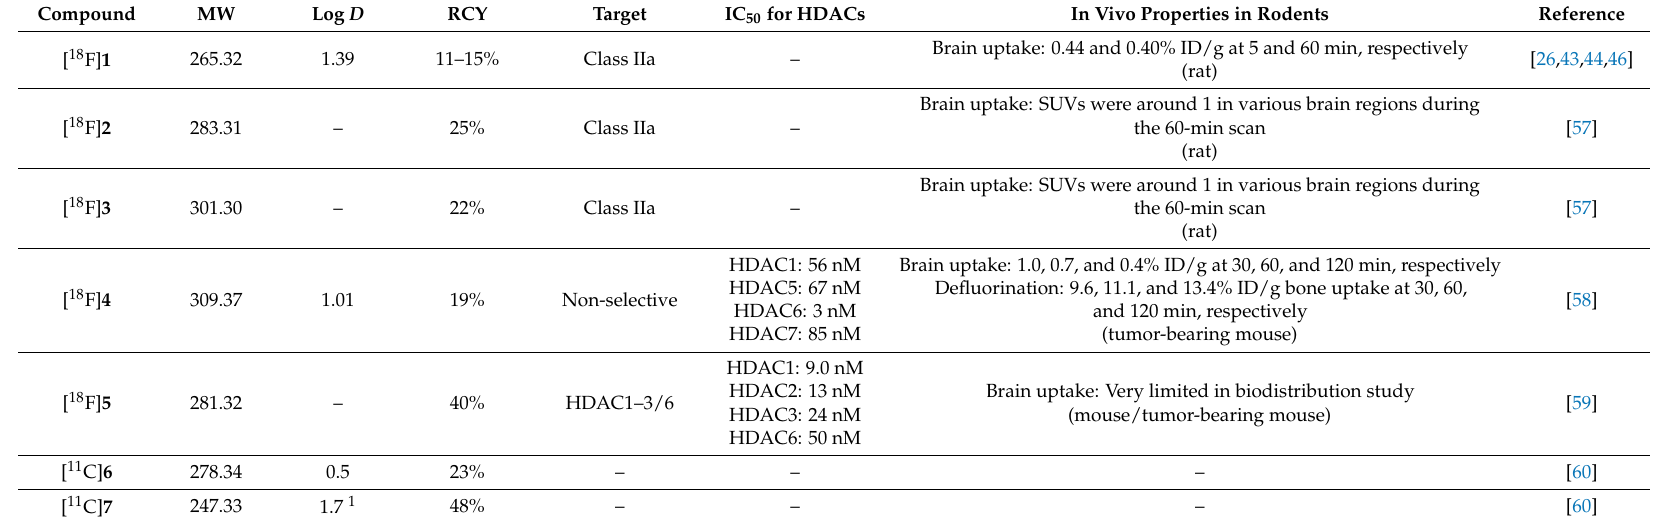
Table 1. Physiochemical properties of radiolabeled SAHA-based HDAC